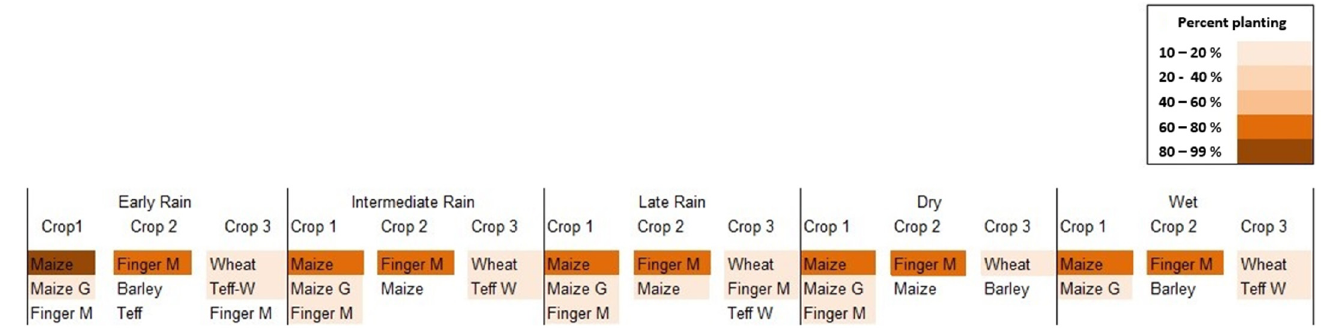
Figure 2. Farmers’ crop planting preferences under different rainfall conditions. Each vertical grouping represents the rainfall condition for the season. Crops 1, 2, and 3 represent farmers’ first, second, and third choices, respectively, of crops to plant for each rainfall condition. The colors represent the percentage of farmers who make the same choice given each predicted rainfall condition.